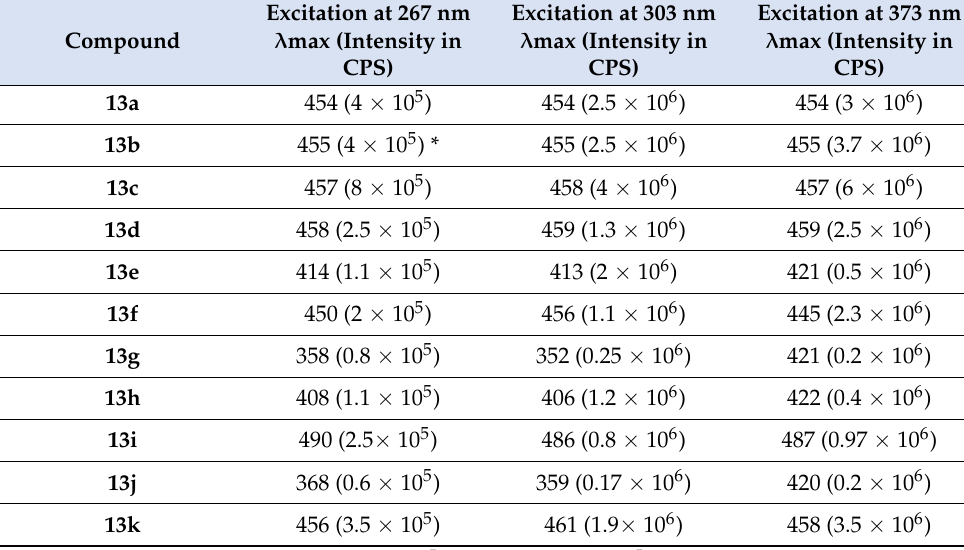
Table 2. Fluorescence emission data ( λ max and intensity) of 13a – k